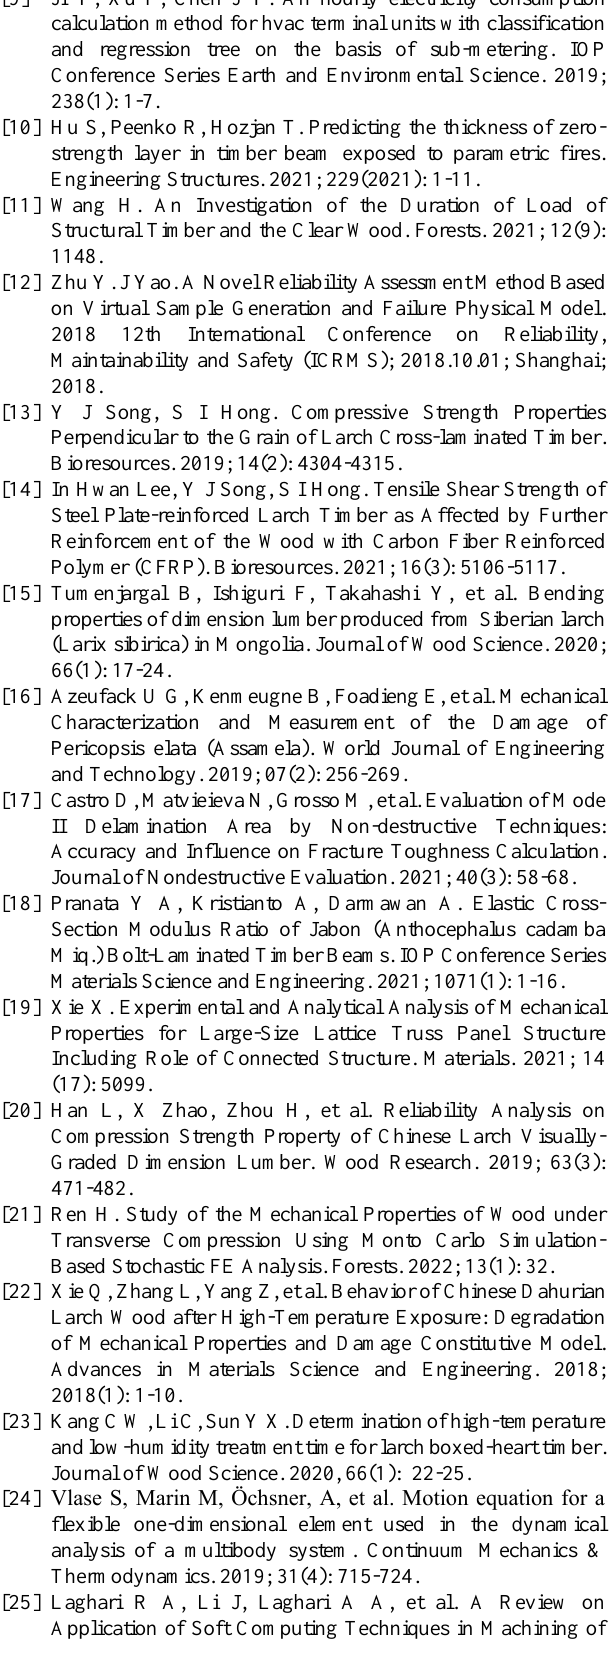
Table 3. Optimize the larch beam section dimensions before and